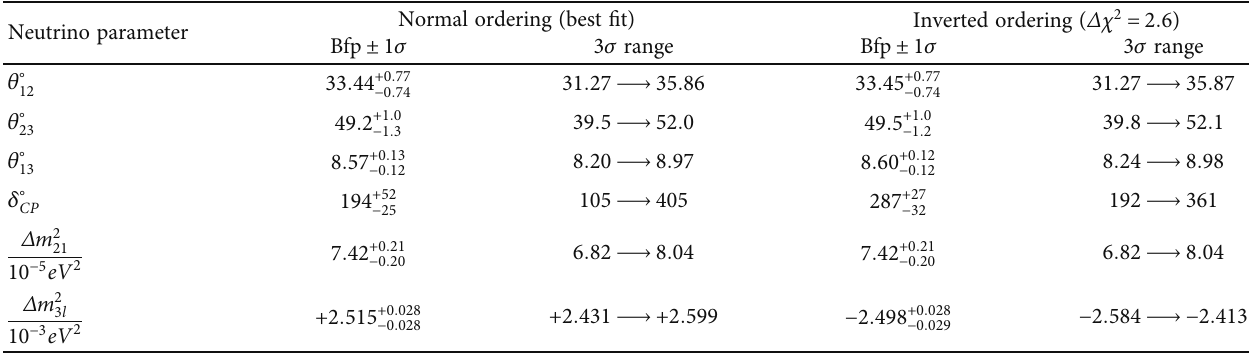
≡ Δ m 2 > 0 for NO and Δ m 2 31 3 l